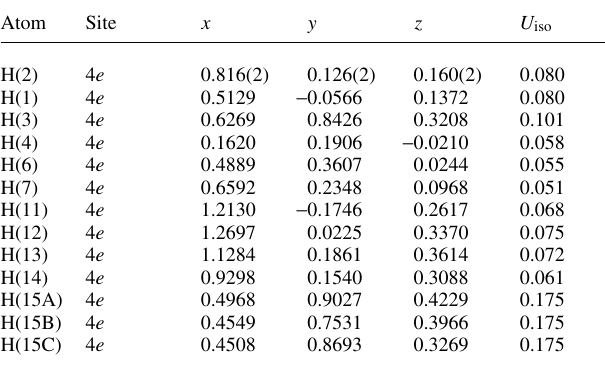
Table 2. Atomic coordinates and displacement parameters (in Å 2 )